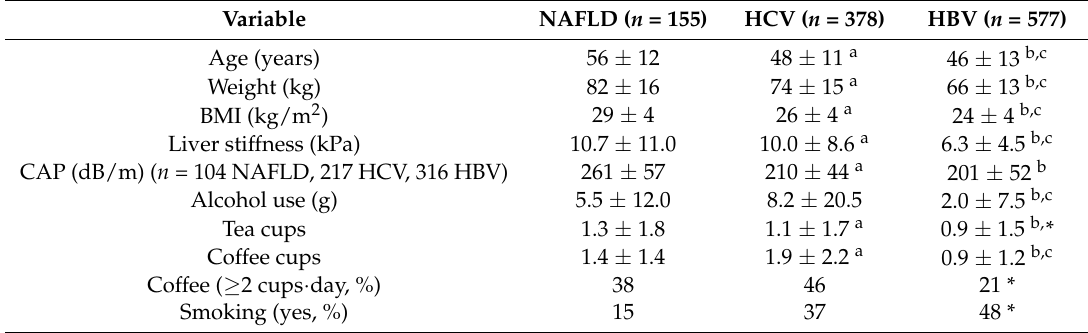
Table 2. Patient characteristics divided by disease state (HBV, HCV, and NAFLD). Variable NAFLD ( n = 155)